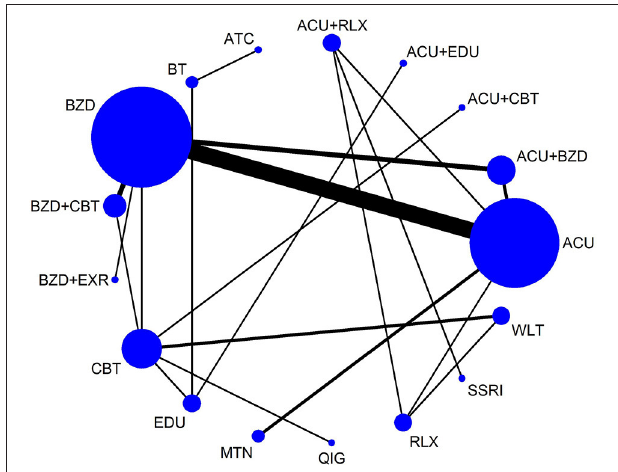
FIGURE 4 | Network map for drop-outs for any reason. ACU, acupuncture; ATC, attention control; BT, behavioral treatment; BZD, benzodiazepines; CBT, cognitive behavioral therapy; EDU, sleep education; EXR, exercise; MTN, melatonin; QIG, qigong; RLX, relaxation; SSRI, selective serotonin reuptake inhibitor; WLT,